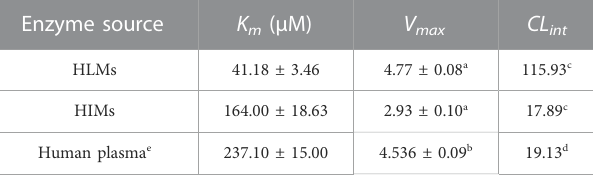
TABLE 3 Kinetic parameters of AB23A hydrolysis in HLMs, HIMs and human plasma. Enzyme source